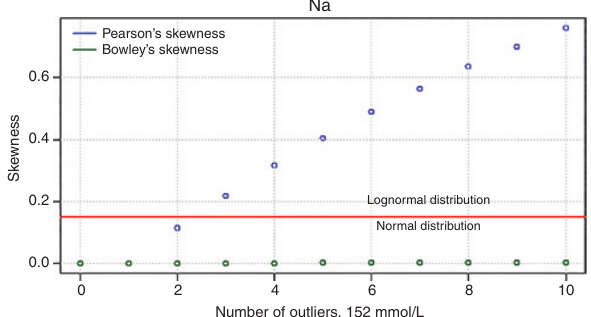
Figure 2: Addition of an increasing number of pathological results (152 mmol/L) to the sodium data of Figure 1. The red line indicates the upper limit of the 95% confidence interval for the classical skewness of a normal distribution at n = 1000.